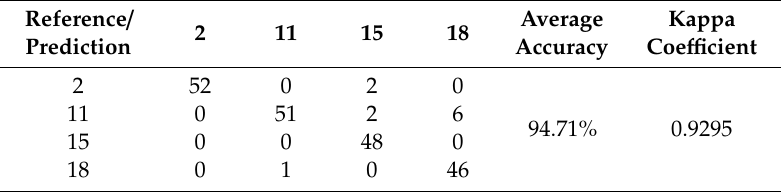
Table 9. Confusion Matrix using the SVM classifier in zones 2, 11, 15 and